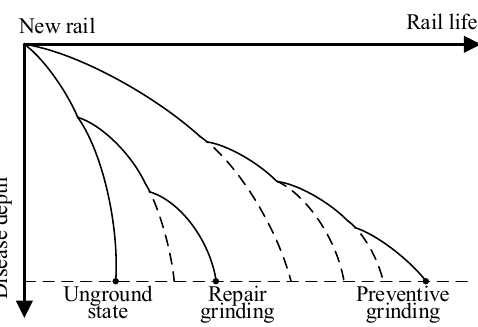
Figure 2. Relationship between rail life and damage according to grinding methods.